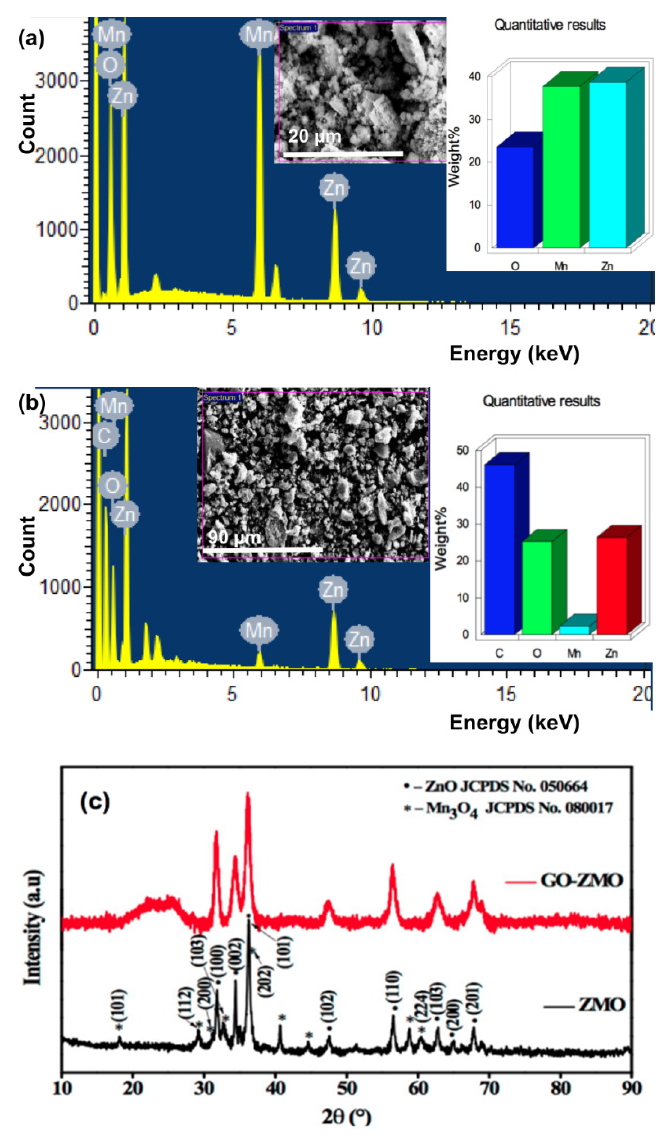
Figure 3. ( a ) EDS XRD of Mn x Zn 1 − x O with (inset) showing the image of Mn x Zn 1 − x O and quantitative analysis revealing 37.7% of Mn ( b ) EDS XRD of GO-Mn x Zn 1 − x O nanocomposite (inset) shows SEM image along with quantitative analysis of GO-Mn x Zn 1 − x O nanocomposite; the Mn and Zn constituted 2.23% and 26.39%, respectively, ( c ) HR-XRD of Mn x Zn 1 − x O and GO-Mn x Zn 1 − x O nanocomposite.